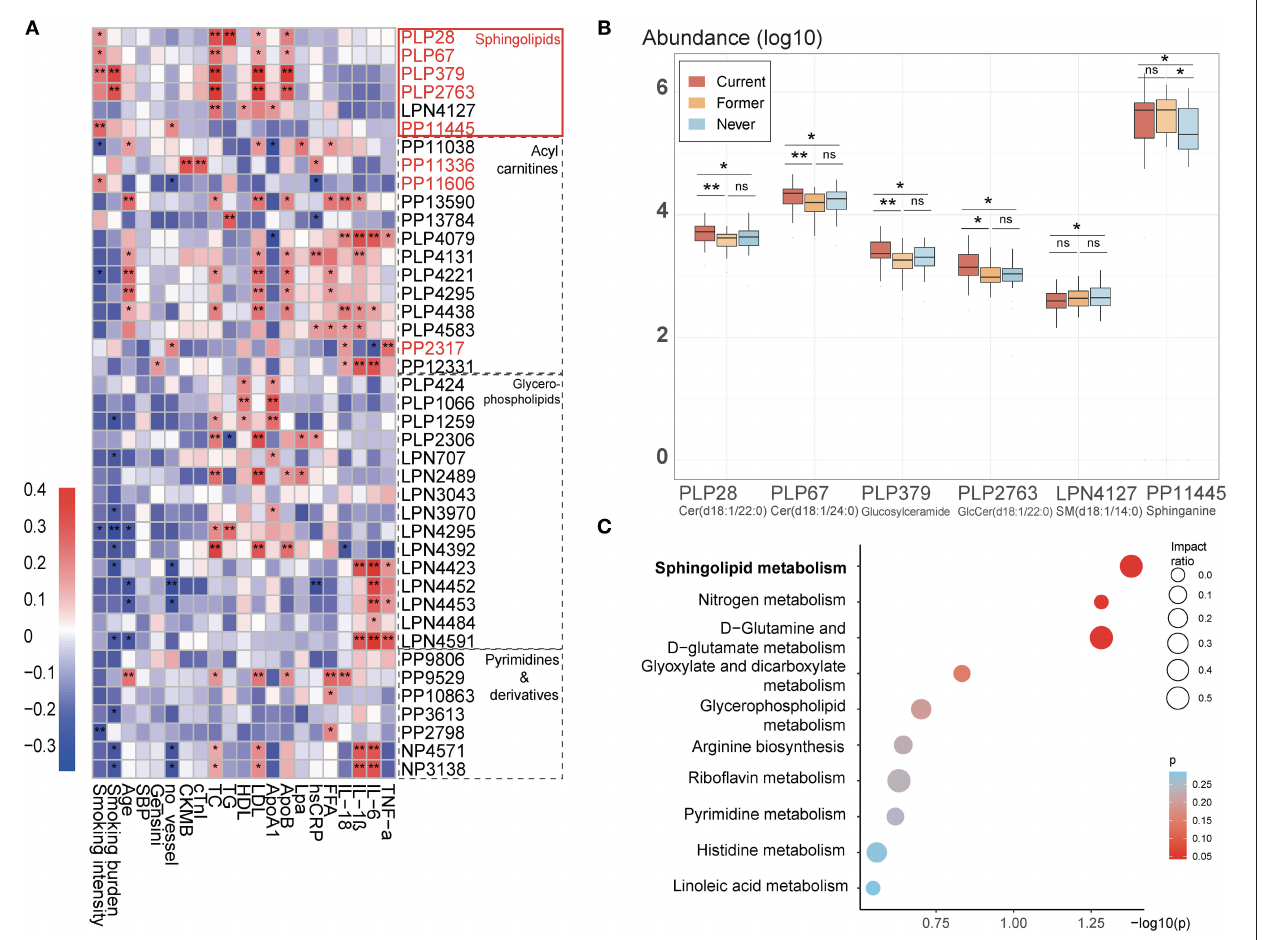
FIGURE 3 | Changes of four groups of important smoking-associated serum metabolomic features. (A) Spearman correlations between smoking-associated metabolomic features in four main groups and major risk factors for CAD. The IDs of metabolic features highlighted in red are smoking-positive. Lpa, lipoprotein (a); ApoB, apolipoprotein B; FFA, free fatty acid; ApoA1, apolipoprotein A1. There is a remarkable elevation in sphingolipids, which is correlated with CAD phenotypes. * p < 0.05, ** p < 0.01. (B) Relative abundance of six metabolites belonging to the class of sphingolipids among three groups. ns: not significant, * p < 0.05, ** p